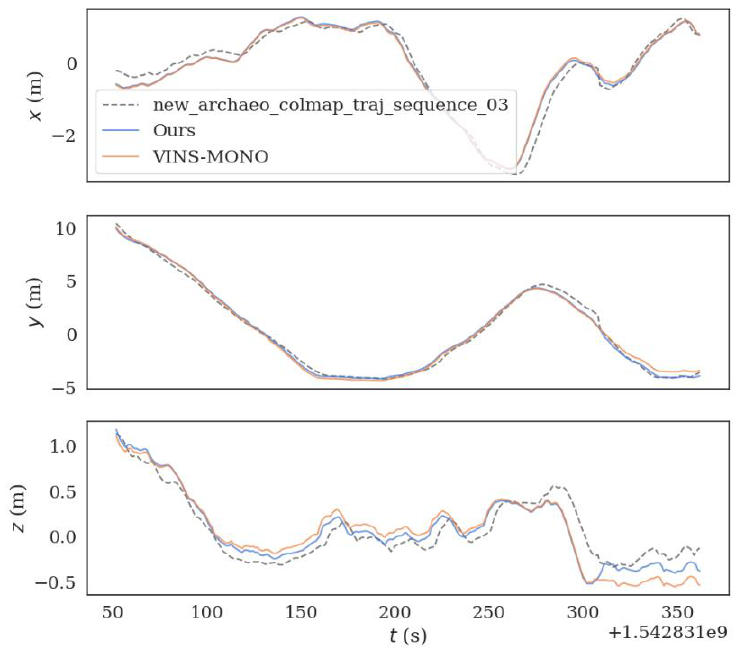
Figure 9. The figure shows the translation error comparison between the original algorithm and the improved algorithm in sequence_03.bag datasets.